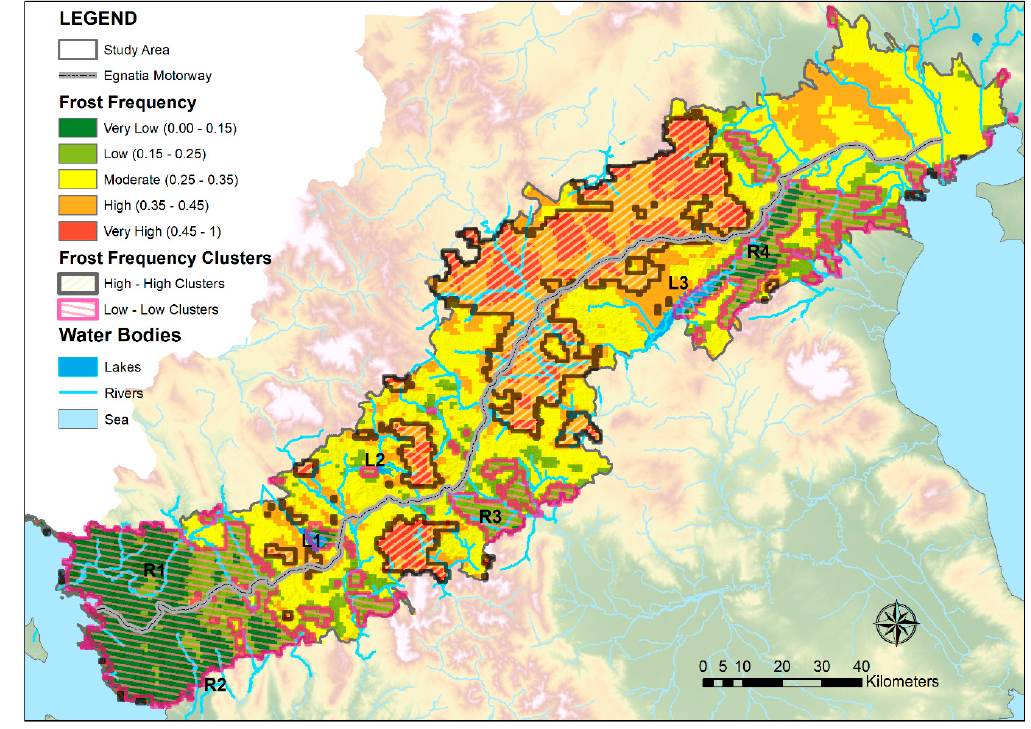
Figure 10. Frost frequency map, displaying the high and low frost frequency clusters and the drainage network of the study